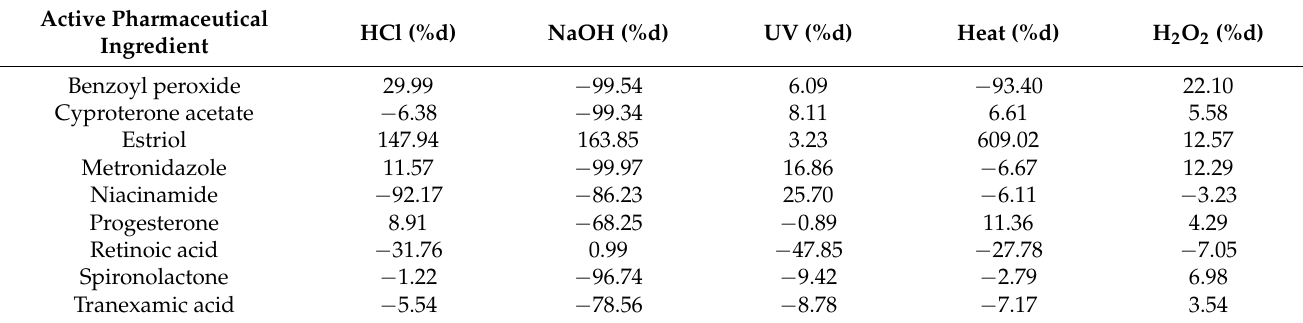
Table 4. Summary of the study indicating the stability of the